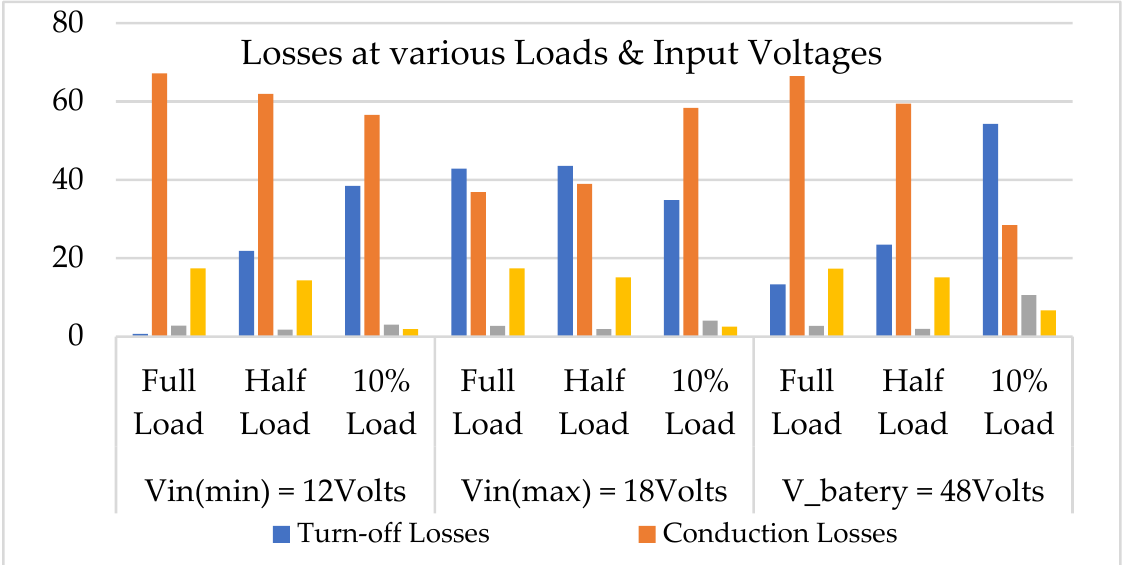
Figure 14. Conduction, turn-off, transformer and body diode losses of the CFIBDC converter at various input voltages ( V in(min) , V in(max) and V o ) and loads (100%, 50% and 10% of load).